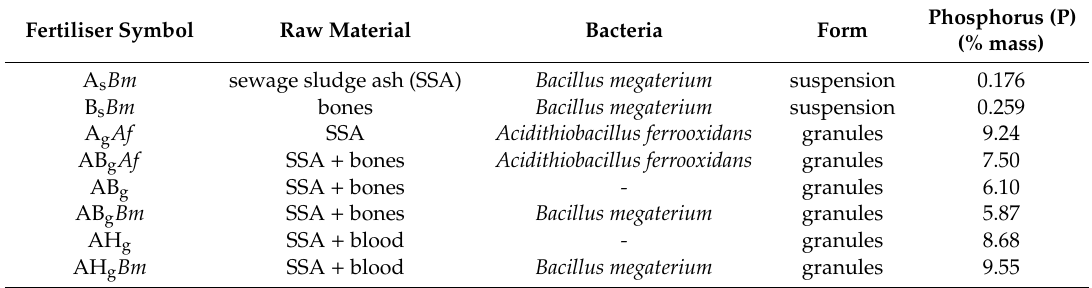
Table 1. Recycled fertilisers tested in the experiments.